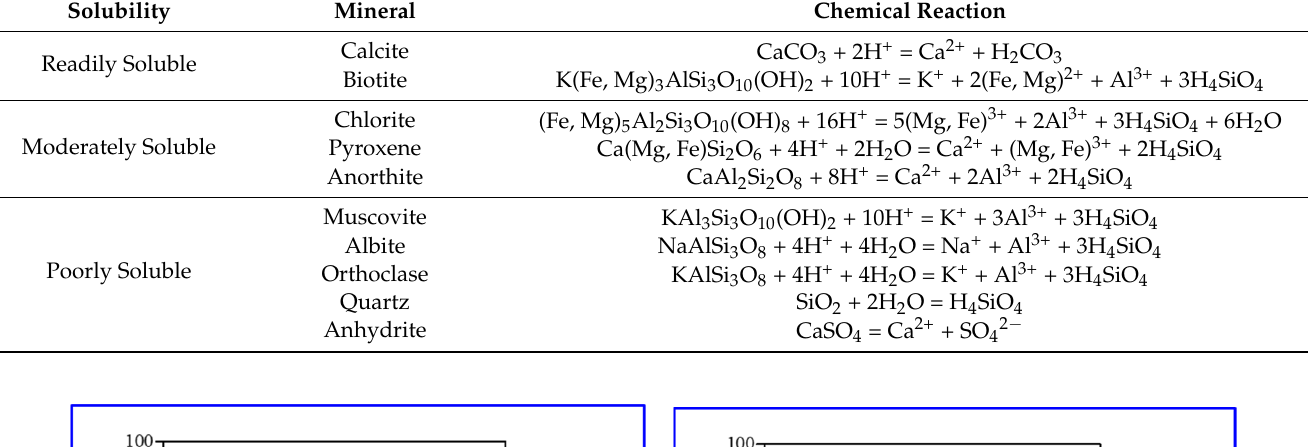
Table 3. Acid dissolution of typical gangue minerals.